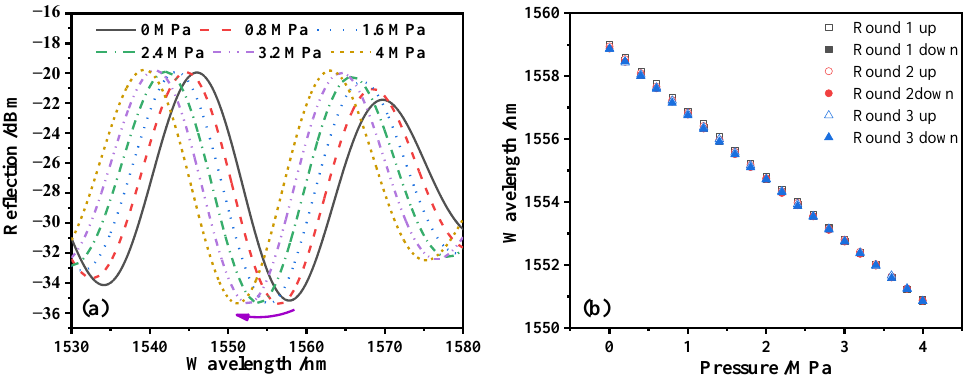
Figure 7. The reflection spectrum of the sensor under different pressures. ( a ) The spectrum shifting trend during rising pressure; ( b ) the three rounds’ sensitivity curve during the rising and dropping pressure.